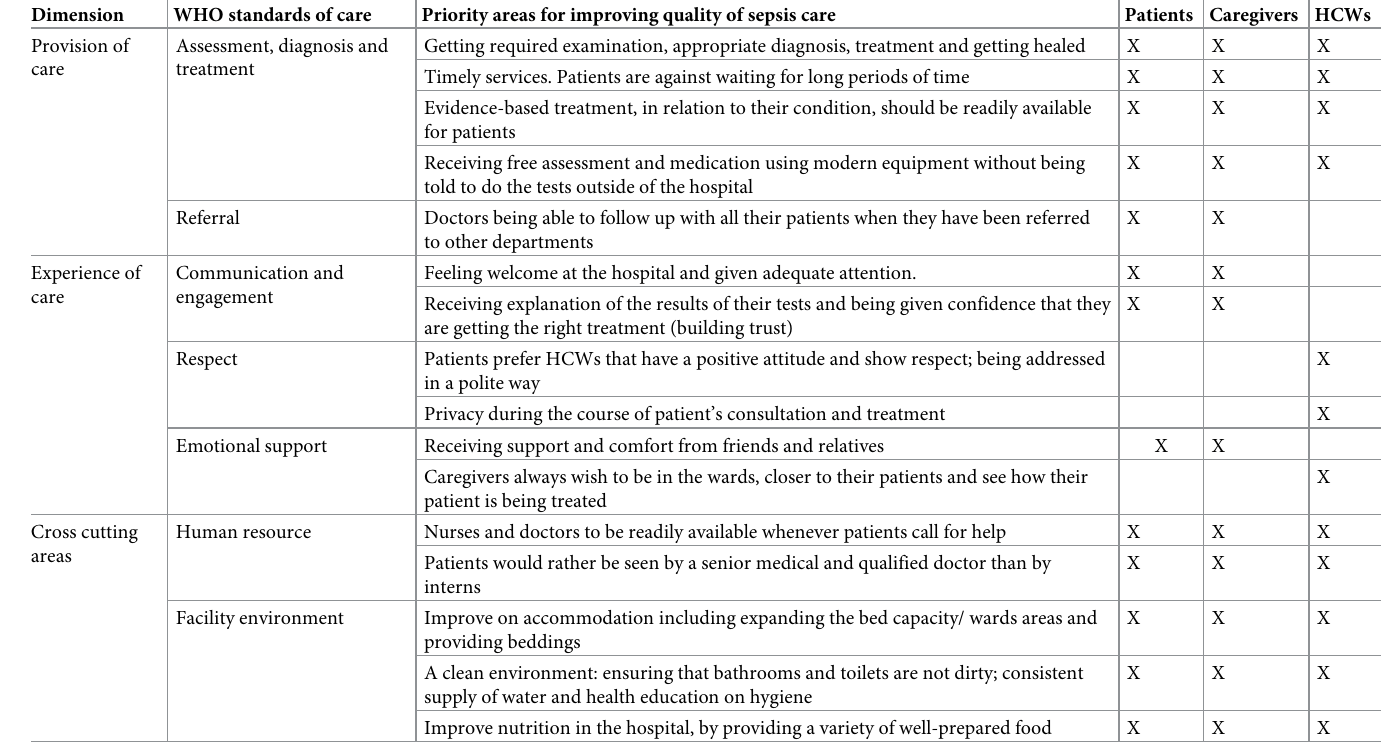
Table 2. Priorities in improving the quality of sepsis care from the perspective of patients with sepsis, their caregivers and HCWs aligned with elements of the WHO standards for improving quality of maternal and neonatal care. Dimension WHO standards of care Priority areas for improving quality of sepsis care Assessment, diagnosis and